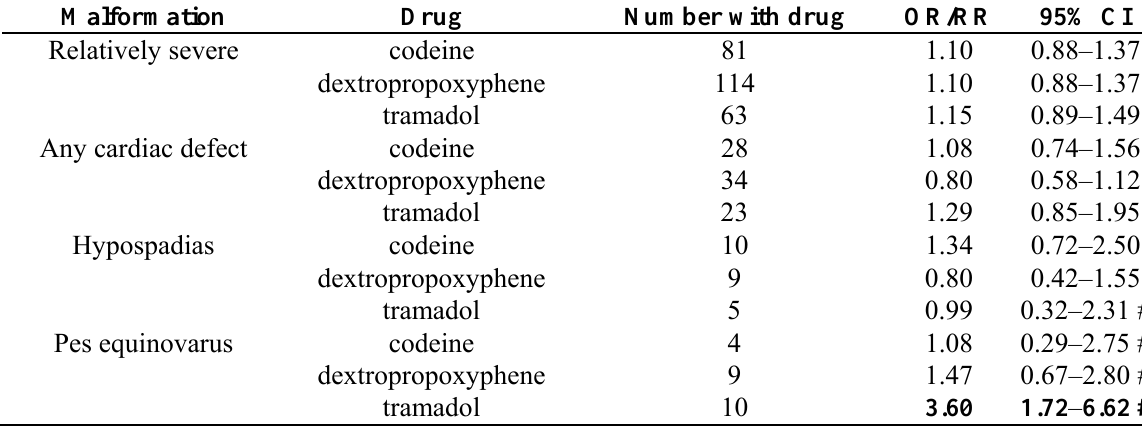
Table 9. Congenital malformations among infants exposed in early pregnancy for three specific opioids. Codeine +paracetamol; dextropropoxyphene, possibly with paracetamol or ASA, and tramadol. Bold text marks statistical